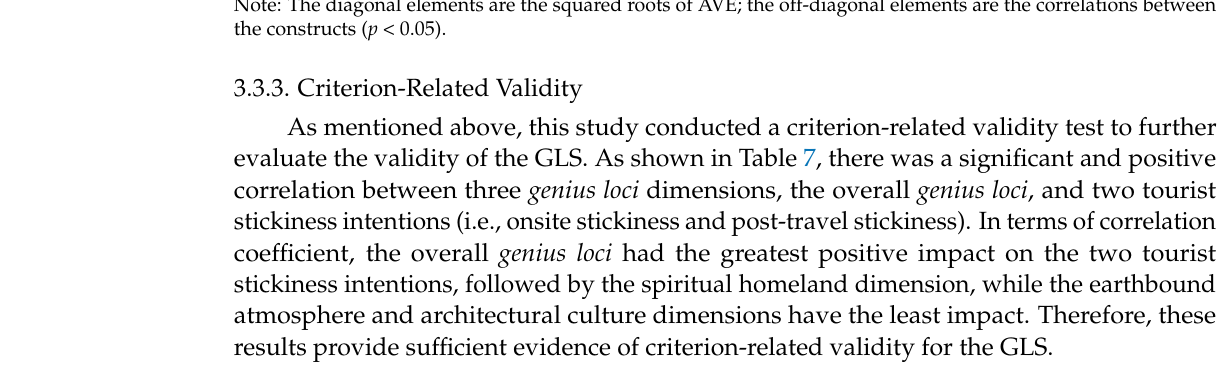
Table 7. Path analysis results for genius loci subscales predicting stickiness intention (Sample 2, n =